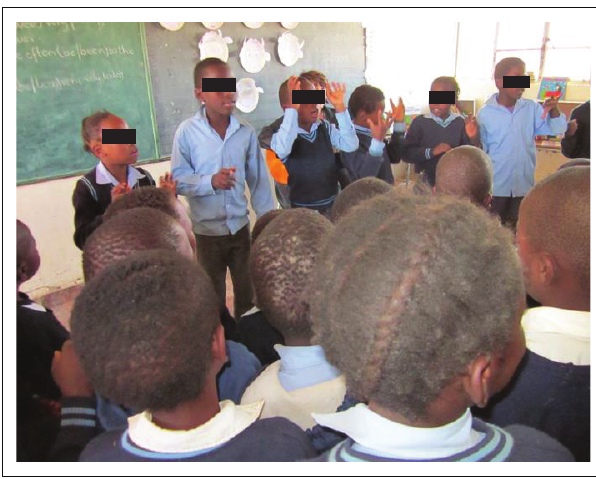
FIGURE 2: Interactive concert that took place at the end of the project including the entire